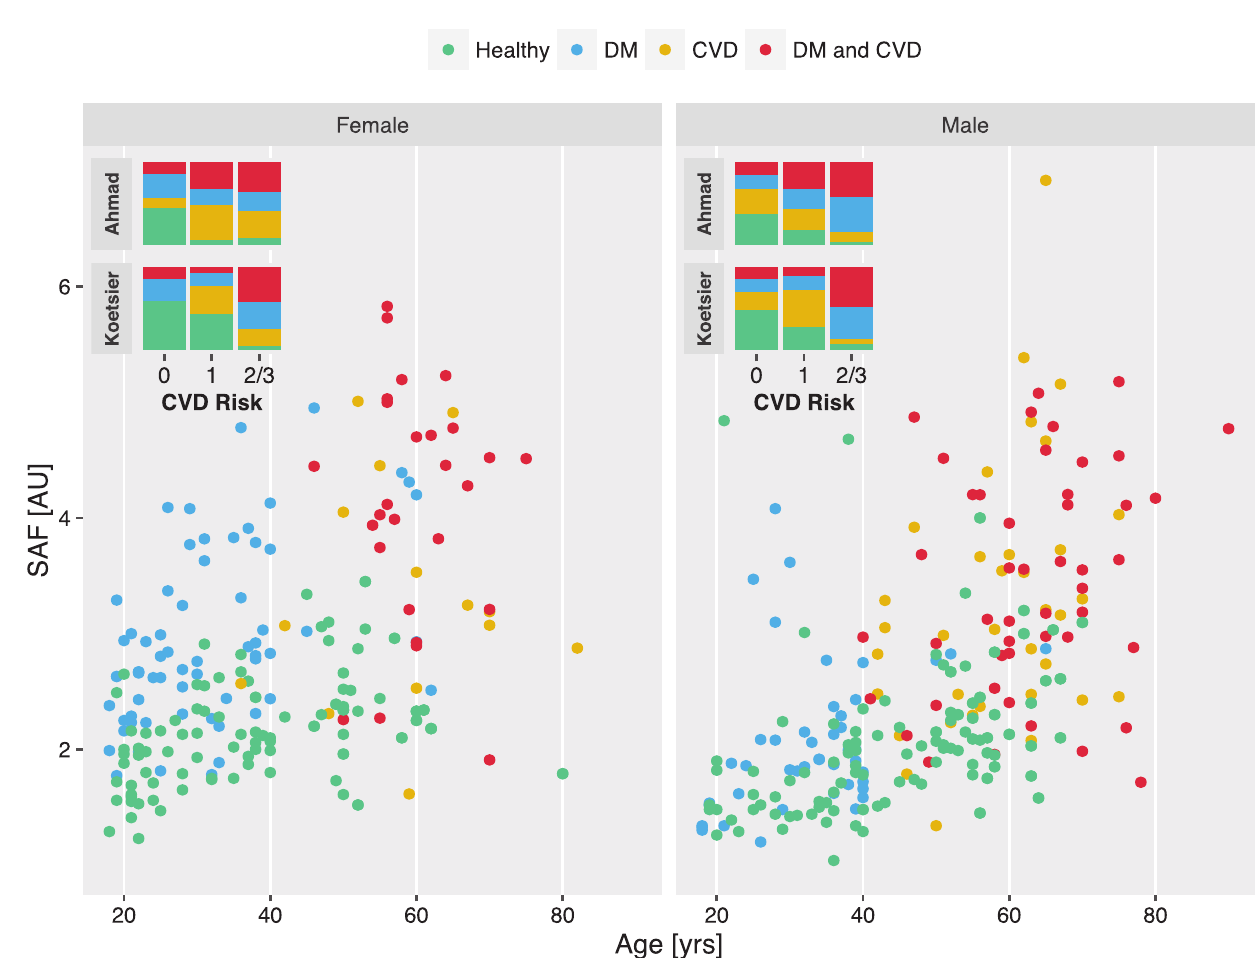
Fig 2. Comparison of SAF intensities between healthy individuals and CVD patients with and without diabetes in an Arab cohort. Insets show the distributionof risk groups as calculatedwith the established risk enginethat is implemented in the AGE-Reader apparatusand the adjusted risk scheme for MiddleEastern populations, both describedin Ahmad et al .